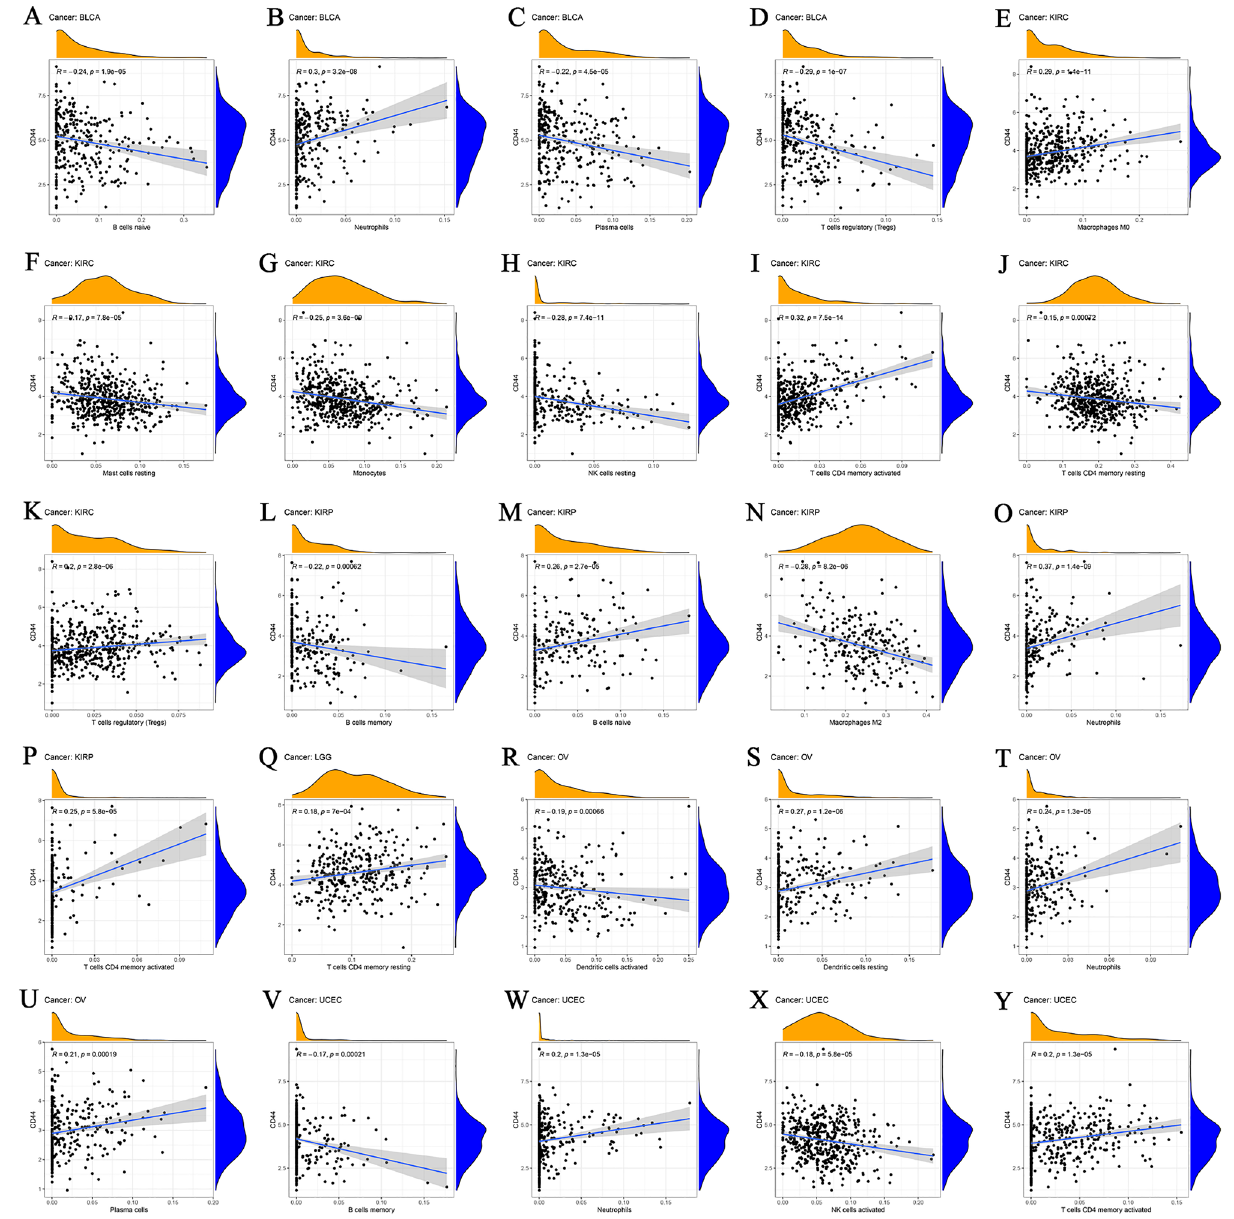
Figure 4. Correlation between the infiltrating status of immune cells with CD44 expression in BLCA ( A – D ), KIRC ( E – K ), KIRP ( L – P ), LGG ( Q ), OV ( R – U ), and UCEC ( V – Y ). BLCA bladder urothelial carcinoma, KIRP kidney renal papillary cell carcinoma, LGG brain lower grade glioma, OV ovarian serous